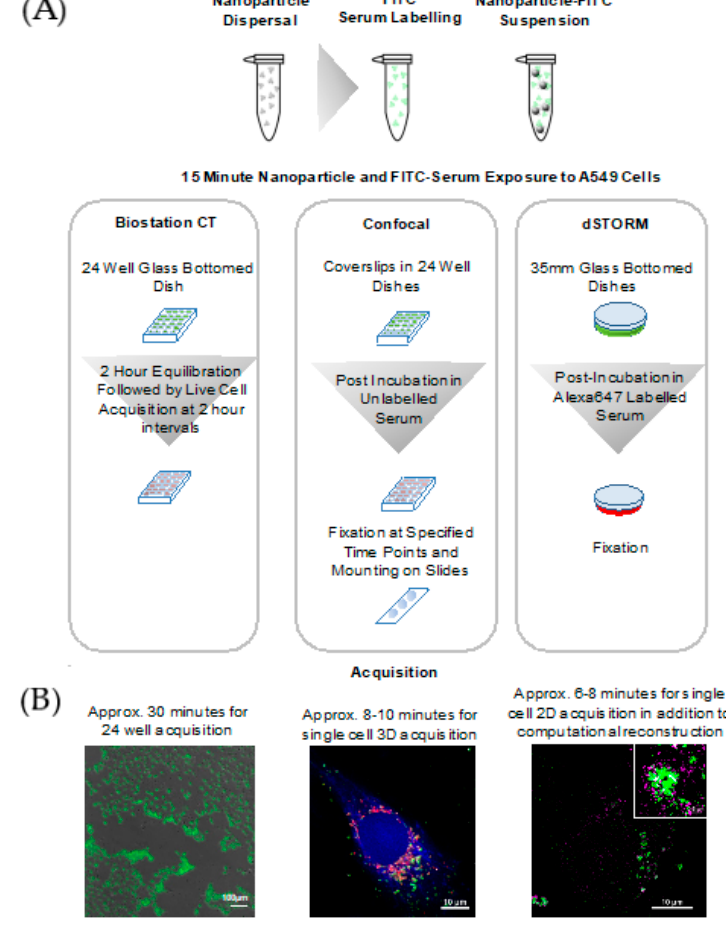
Figure 1. Imaging workflow applied to investigate the e ff ect of the surface coating composition on the uptake, tra ffi cking, and corona kinetics of titanium oxide (TiO 2 ) nanomaterials (NMs). ( A ) Serum containing media is labeled with fluorescein isothiocyanate (FITC) prior to incubation with TiO 2 NMs. ( B ) Adenocarcinomic human alveolar basal epithelial (A549) cells are then exposed to TiO 2 NMs in FITC-serum for 15 min before subsequent washes and post incubation in either unlabeled serum (Biostation CT and confocal experiments) or Alexa-647-labeled serum (dSTORM). Images were acquired over relevant time points and analyzed for a quantitative comparison of the e ff ects of di ff erent coating surface